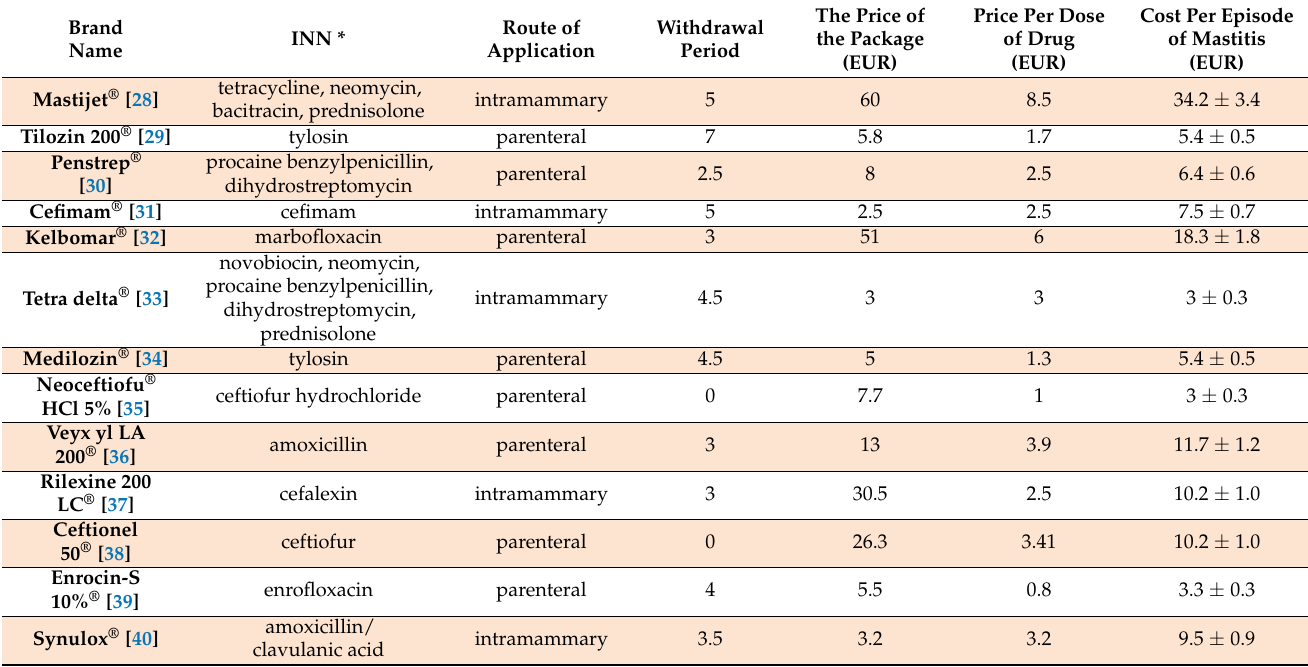
Table 2. The antibiotics used in mastitis